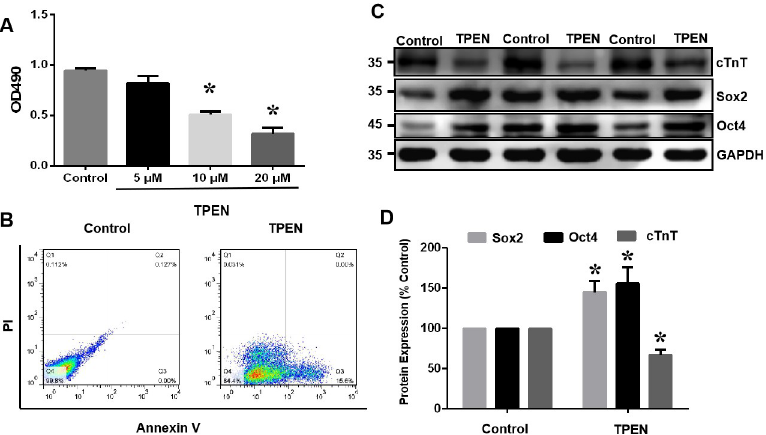
Fig 6. Zinc deficiency affects apoptosis, activity, and differentiation of hiPSC-CMs. (A) Cell viability. Compared with the control, TPEN (5, 10, and 20 μ M) significantly decreased hiPSC-CM viability. Values are presented as the mean ± SD. Statistical significance was analyzed using Tukey’s test. � P < 0.05 vs. control (n = 6). (B) Flow cytometric analysis of the apoptotic state. Compared with the control, the selective zinc chelator TPEN (10 μ M, 2 h) significantly increased apoptosis of hiPSC-CMs (n = 3). (C) Western blotting of Sox2, Oct4 and cTnT protein expression. In the zinc-deficient state, the expression levels of TnT were decreased in hiPSC-CMs, while the expression level of stem cell marker, Sox2 and Oct4 were increased (n = 6). (D) Summarized data of (C). Values are presented as the mean ± SD Statistical significance was analyzed using Tukey’s test. � P < 0.05 vs. control.